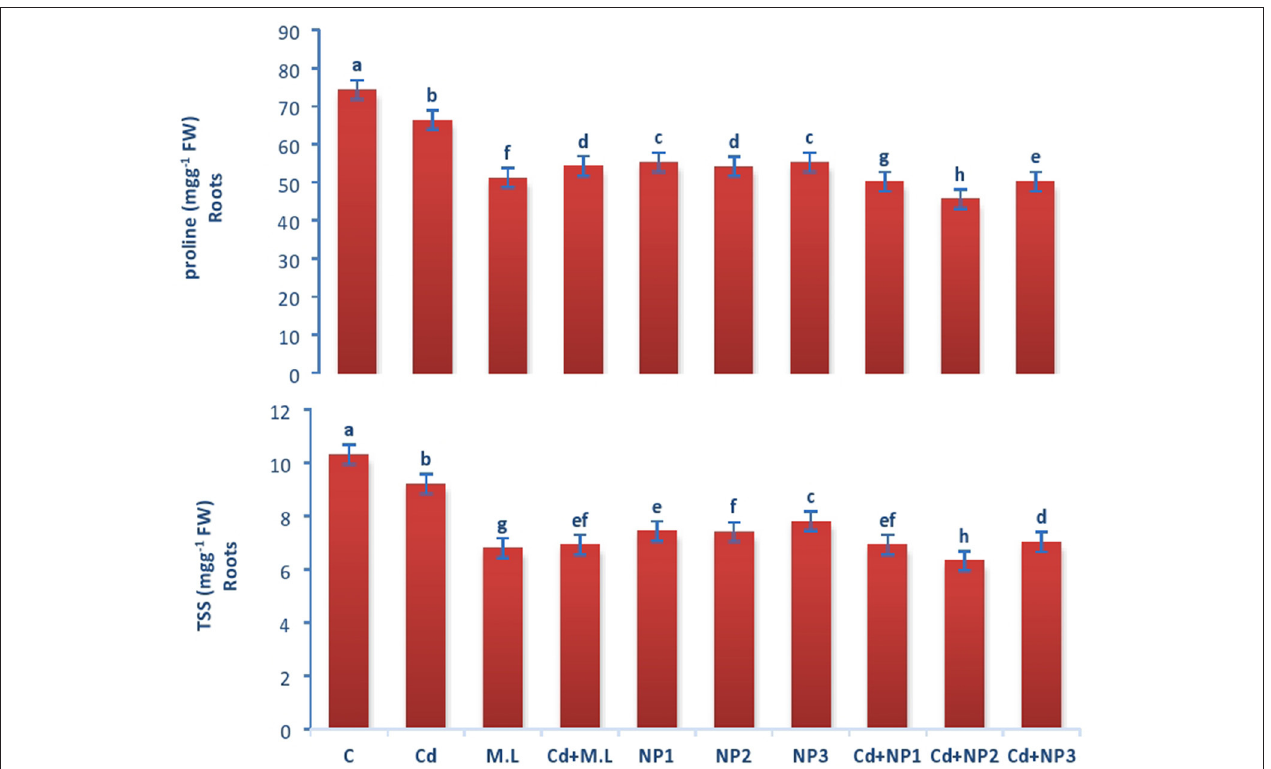
FIGURE 3 | Effects of MZnO–NPs on protein, proline, and TSS under Cd stress in Linseed roots. Different letters indicate significant difference between the treatments. Data are means ± SE ( n = 5). Non-identical letters specify significant difference at P ≤ 0.05. C, Control; Cd, 100mg kg − 1 Cd; M. L, Moringa oleifera leaves; NP1, 100mg L − 1 MZnO-NPs; NP2, 500mg L − 1 MZnO-NPs; NP3, 1g L − 1